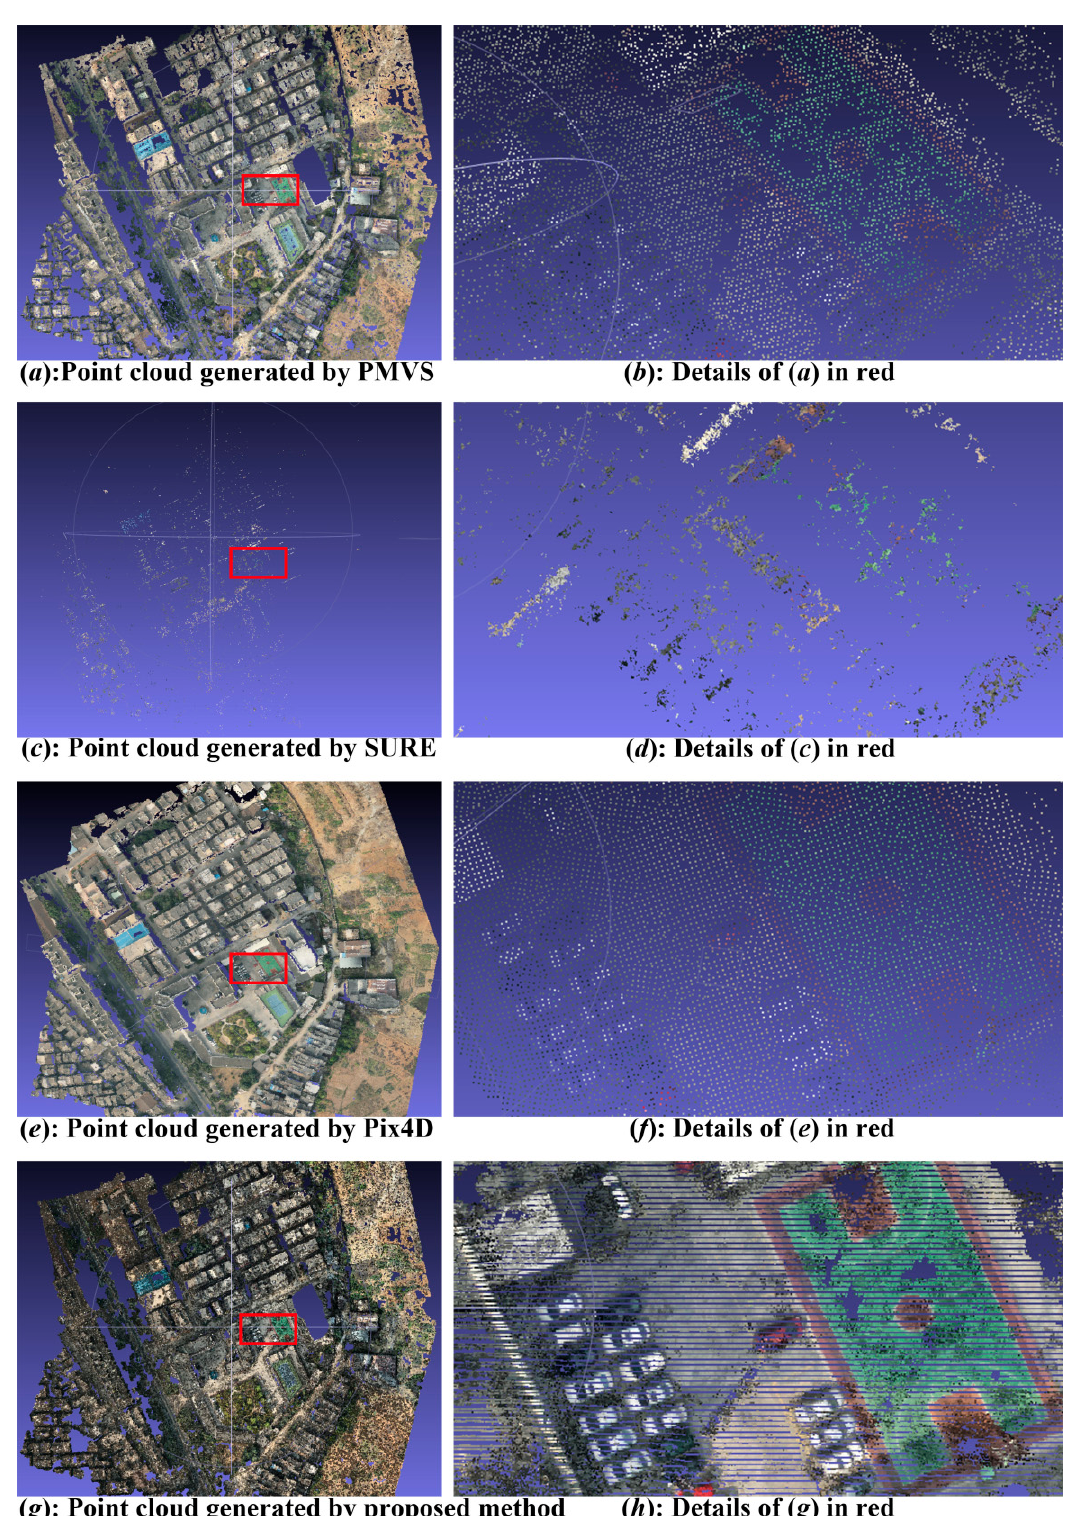
Figure 6. Examples of reconstructed point cloud with Yangjiang images illustrated by software MeshLab. ( a ) Point cloud generated by PMVS; ( b ) Details of (a) in red; ( c ) Point cloud generated by SURE; ( d ) Details of (c) in red; ( e ) Point cloud generated by Pix4D; ( f ) Details of (e) in red; ( g ) Point cloud generated by proposed method; ( h ) Details of (g) in red.